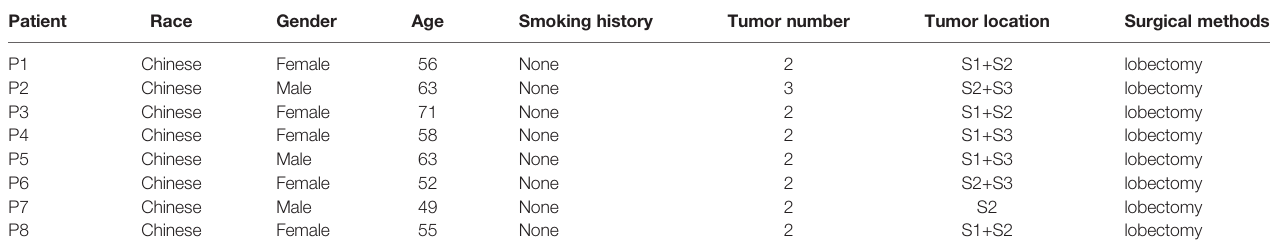
TABLE 1 | Clinical characteristics of